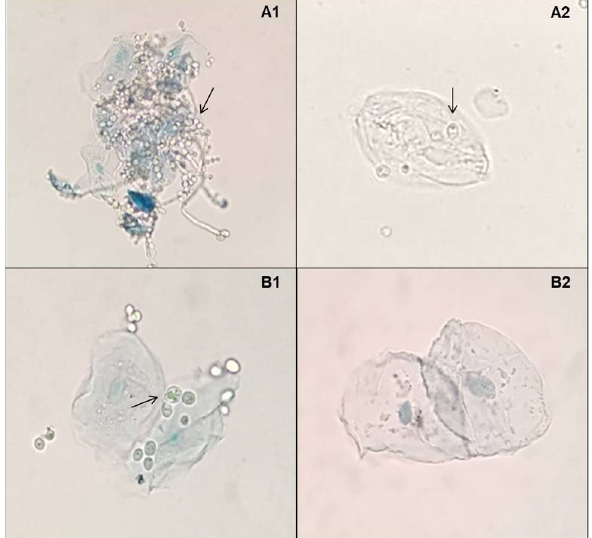
Figure 2. Inhibition of the ability to adherence to Candida parapsilosis complex yeast epithelial cells by D-limonene: ( A1 , A2 ) URM 7445 Candida parapsilosis stricto sensu showed strong adherence before treatment and poor adherence after treatment with D-limonene; ( B1 , B2 ) URM 7434 Candida orthopsilosis revealed poor adherence before treatment and absent adherence after treatment with D-limonene. Arrows indicate yeast cells adhered to human epithelial cells.